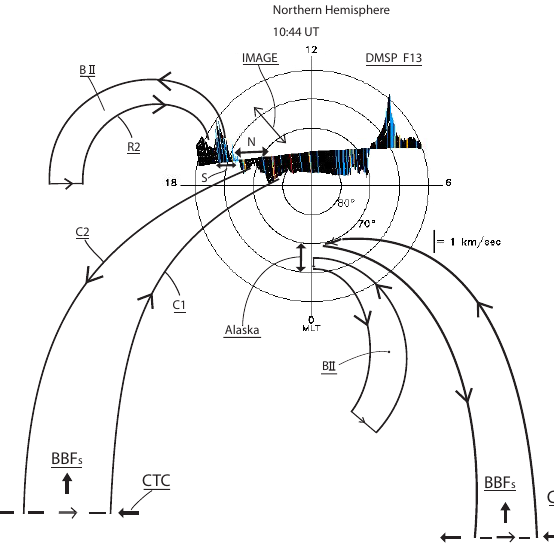
Figure 7. Cross-track ion drift measurements along the DMSP F13 track from dusk to dawn and schematic representation of field- aligned currents (not to scale) between the auroral ionosphere and the magnetosphere at dusk (C1, C2, R2) and near midnight. The satellite crossings of the southern (S) and northern (N) sections of the double oval configuration at dusk is marked. M-I coupling via Bostrøm type I and II current systems in the oval north and oval south regimes, respectively, is schematically illustrated at dusk and midnight. Connections between bursty bulk flows (BBFs) and cross- tail current (CTC) disruptions and oval north regimes are indicated. Approximate fields of view of magnetometer chains in Scandinavia (IMAGE) and Alaska at 10:40UT are marked by double-arrowed meridional lines. MLAT circles at 50, 60, 70, and 80 ◦ are